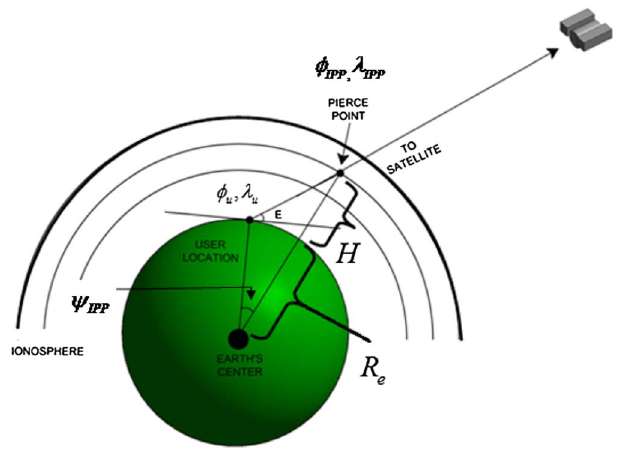
Fig. 1. Receiver satellite